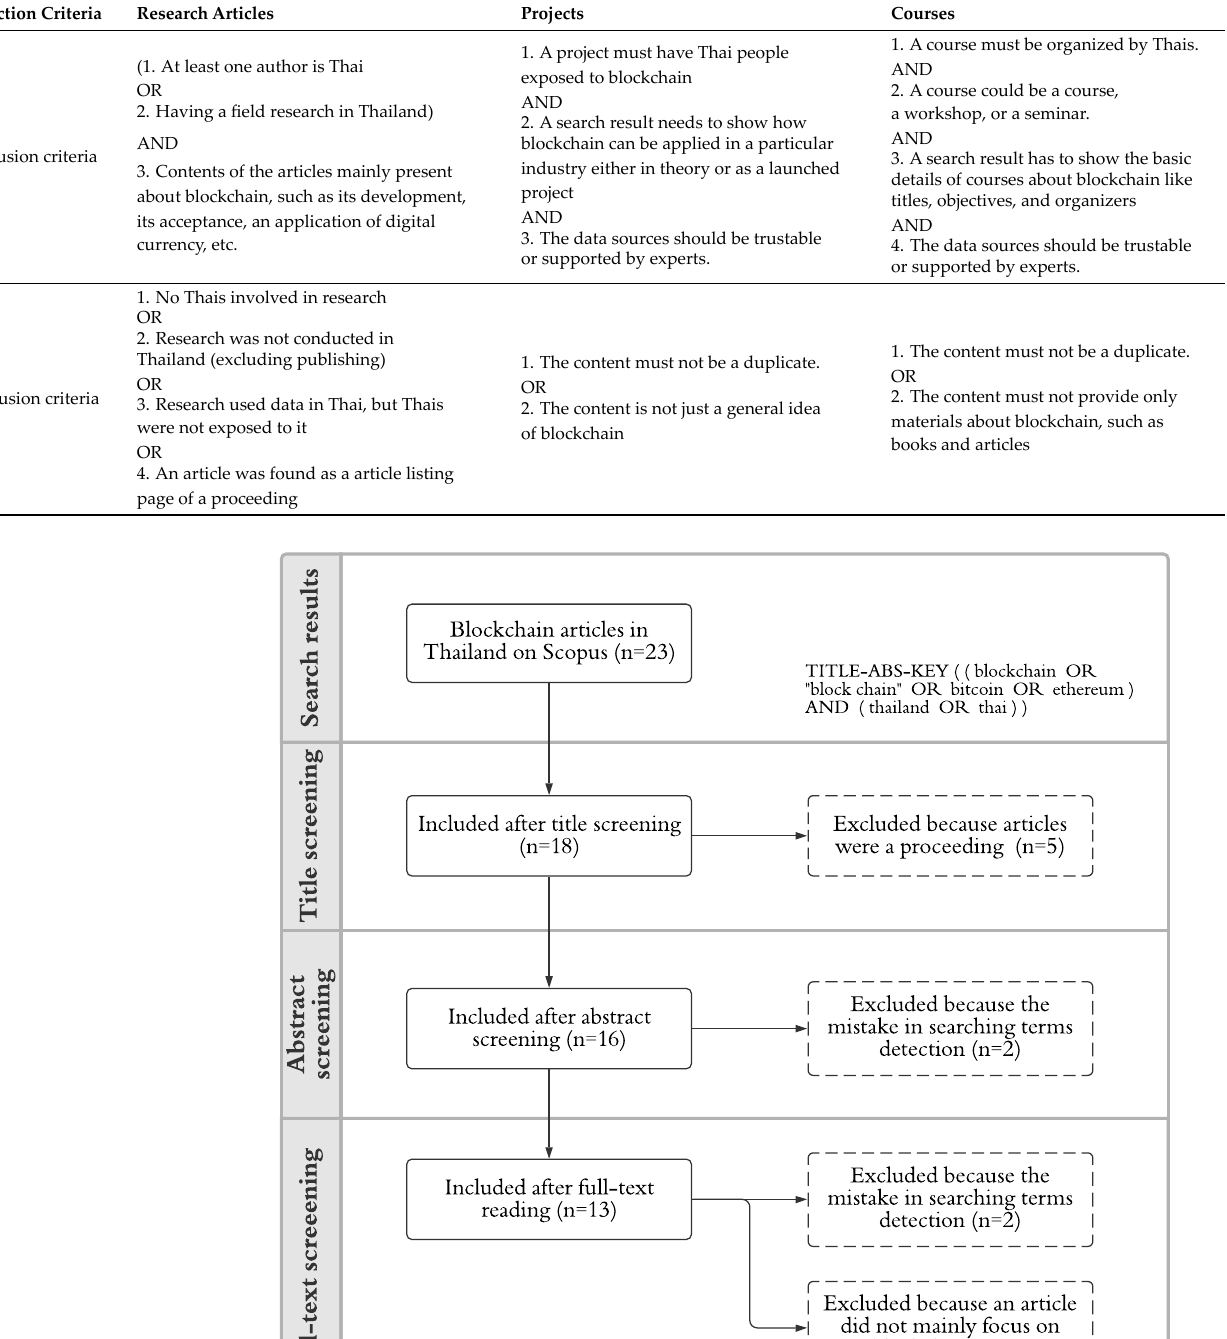
Table 1. Inclusion and exclusion criteria.